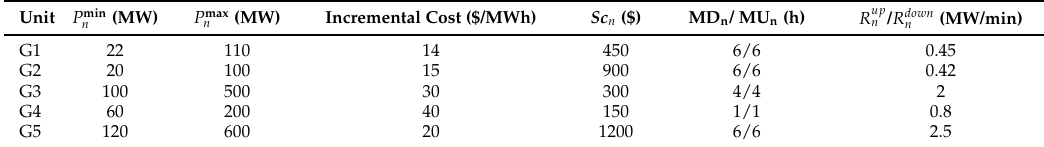
Table 1. Unit characteristics.